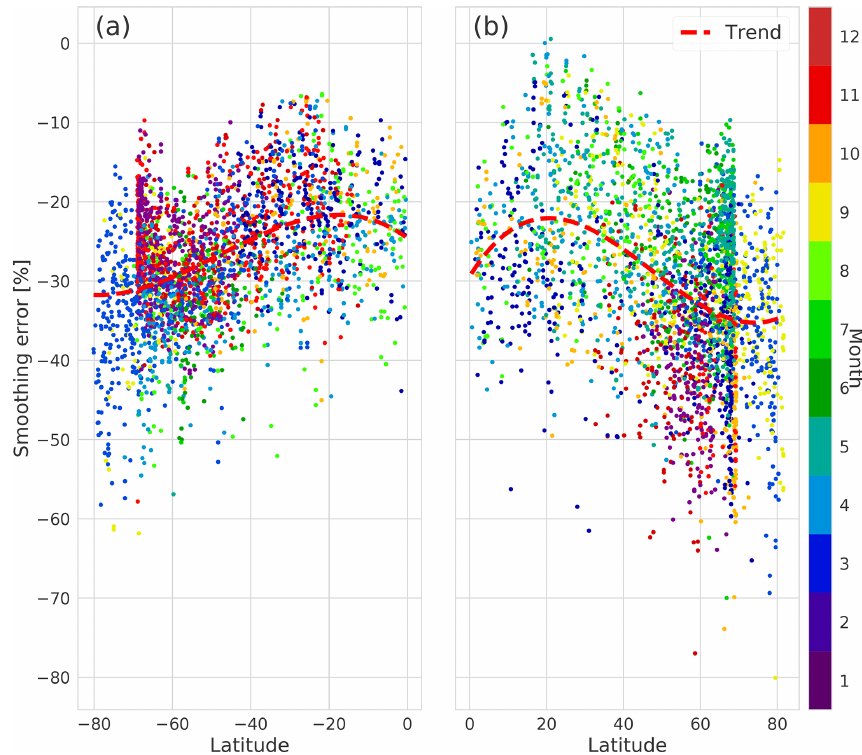
Figure 6. The relative smoothing error of TROPOMI pixels over cloudy scenes in (a) the Southern Hemisphere and (b) the Northern Hemisphere with respect to the true (unsmoothed) ACE-FTS partial columns versus latitude for the period from 28 November 2017 to 31 May 2020. A third-order polynomial fit (denoted by the dashed red line) was applied to the data to better highlight the underlying